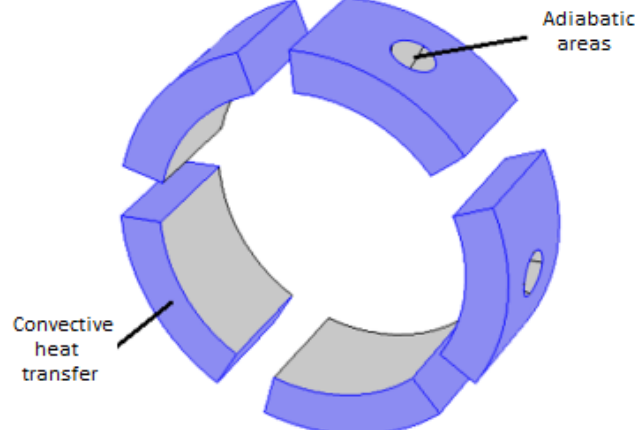
Figure 8. Pads surfaces subjected to heat exchange and adiabatic